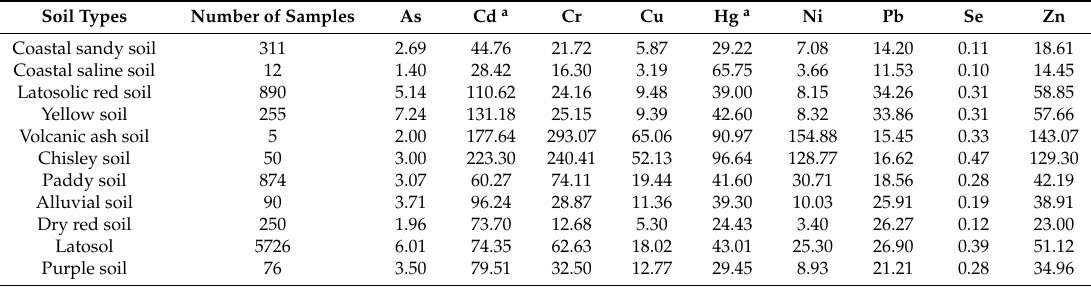
Table 2. Geometrical means of elements in soils (0–20 cm) of Hainan Island of different soil types (means are mg · kg − 1 ).